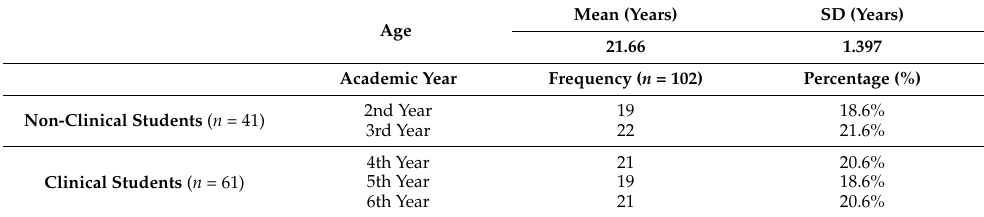
Table 1. Demographic characteristics of participants ( n =